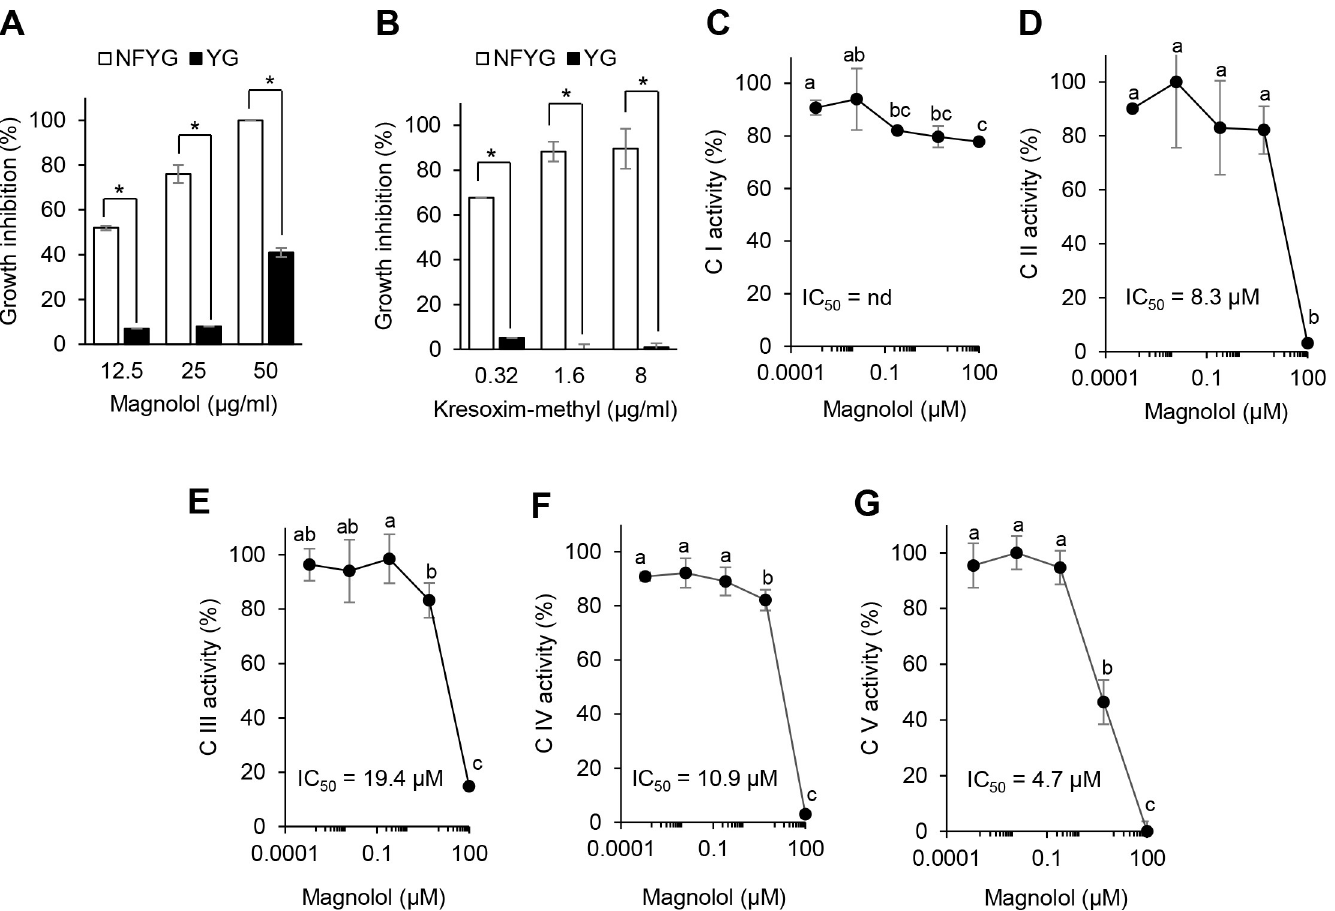
Fig 5. Effects of magnolol on mitochondrial respiratory. Growth comparison of Saccharomyces cerevisiae in NFYG and YG media containing magnolol (A) and kresoxim-methyl (B). (C–G) Effects of magnolol on the mitochondrial respiratory complexes I–V (C I–V). The values represent the mean ± standard deviation of two runs with three replicates. Different letters and asterisks ( � ) indicate significant differences at p < 0.05.